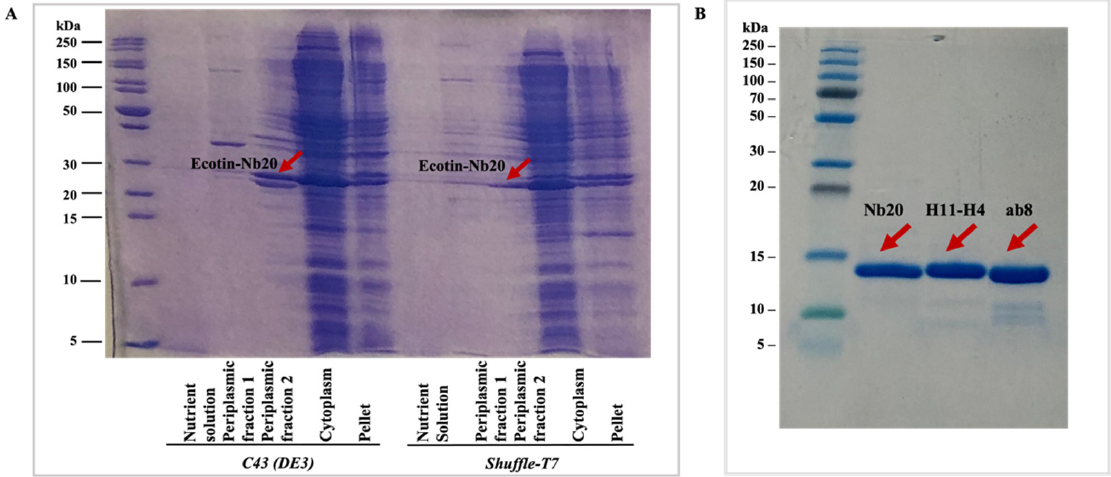
Figure 2. ( A ) Comparison of the fractions after periplasmic isolation (periplasmic isolation step one and step two), cytoplasm ultrasonication, and assessment of the nutrient solution by SDS-PAGE in the case of the expression of the Nb20 nanobody in C43(DE3) and Shuffle-T7 bacterial strains using the Tac-promoter-based construct. Each sample contains 2.5 μ L of sample mixed with 2x SDS load- ing dye. ( B ) Comparison of the purified nanobodies by SDS-PAGE in the case of the expression in Shuffle-T7 bacterial strain using the Tac-promoter-based construct. Each sample contains 2.5 μ L of sample mixed with 2x SDS loading